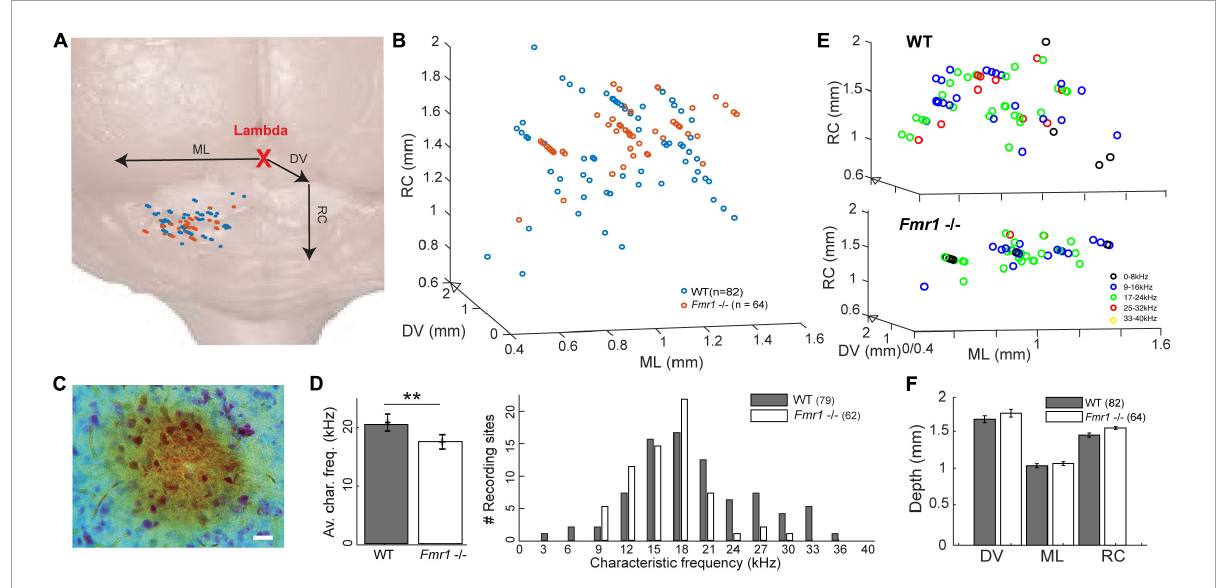
FIGURE1 Location of the recorded IC neurons, with their characteristic frequencies. (A) Schematic reconstruction of stereotactic recording locations on top of a schematic brain picture, (orange) Fmr1 -/- neurons, (blue) WT. (B) 3D-reconstruction of the different stereotactic locations. (C) Picture of an HRP staining (20 µ m). (D) (right) Histogram of all CFs. (Left) Averaged CF in the WT vs. Fmr1 -/- mice. (E) 3D stereotactic locations represented with color-coded CF (dark low, light color higher frequencies) in (up) all WT neurons, (down) all Fmr1 -/- neurons. (F) Averaged positions of all cells’ stereotactic locations in WT and Fmr1 -/-